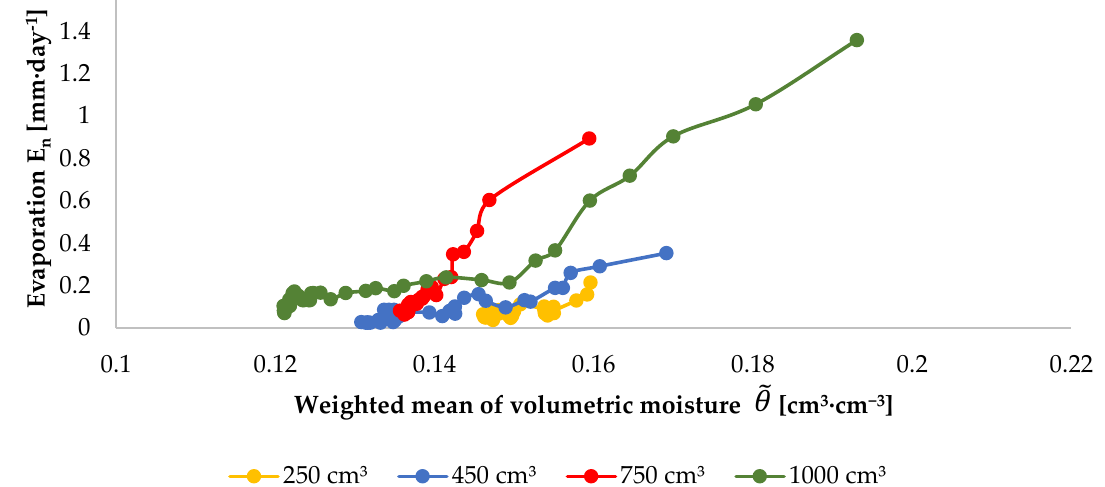
Figure 9. Evaporation versus weighted mean of volumetric moisture of soil after the injection of 250, 450, 750 and 1000 cm 3 of water at the depth of 10 cm.